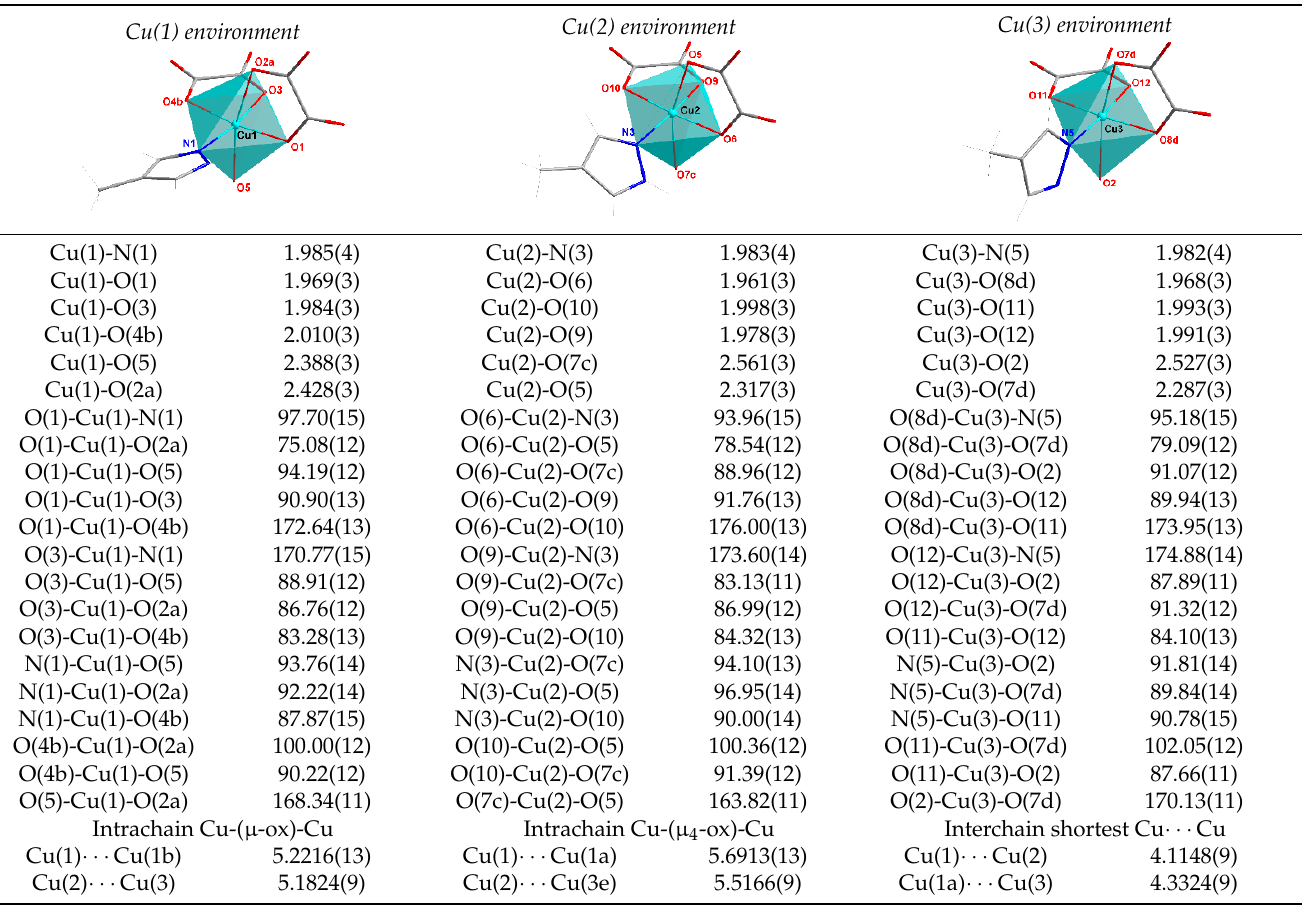
Table 2. Selected bond distances (Å) and angles (°), and intra- and inter-chain Cu···Cu distances (Å) for 1 1 . Cu(1) environment